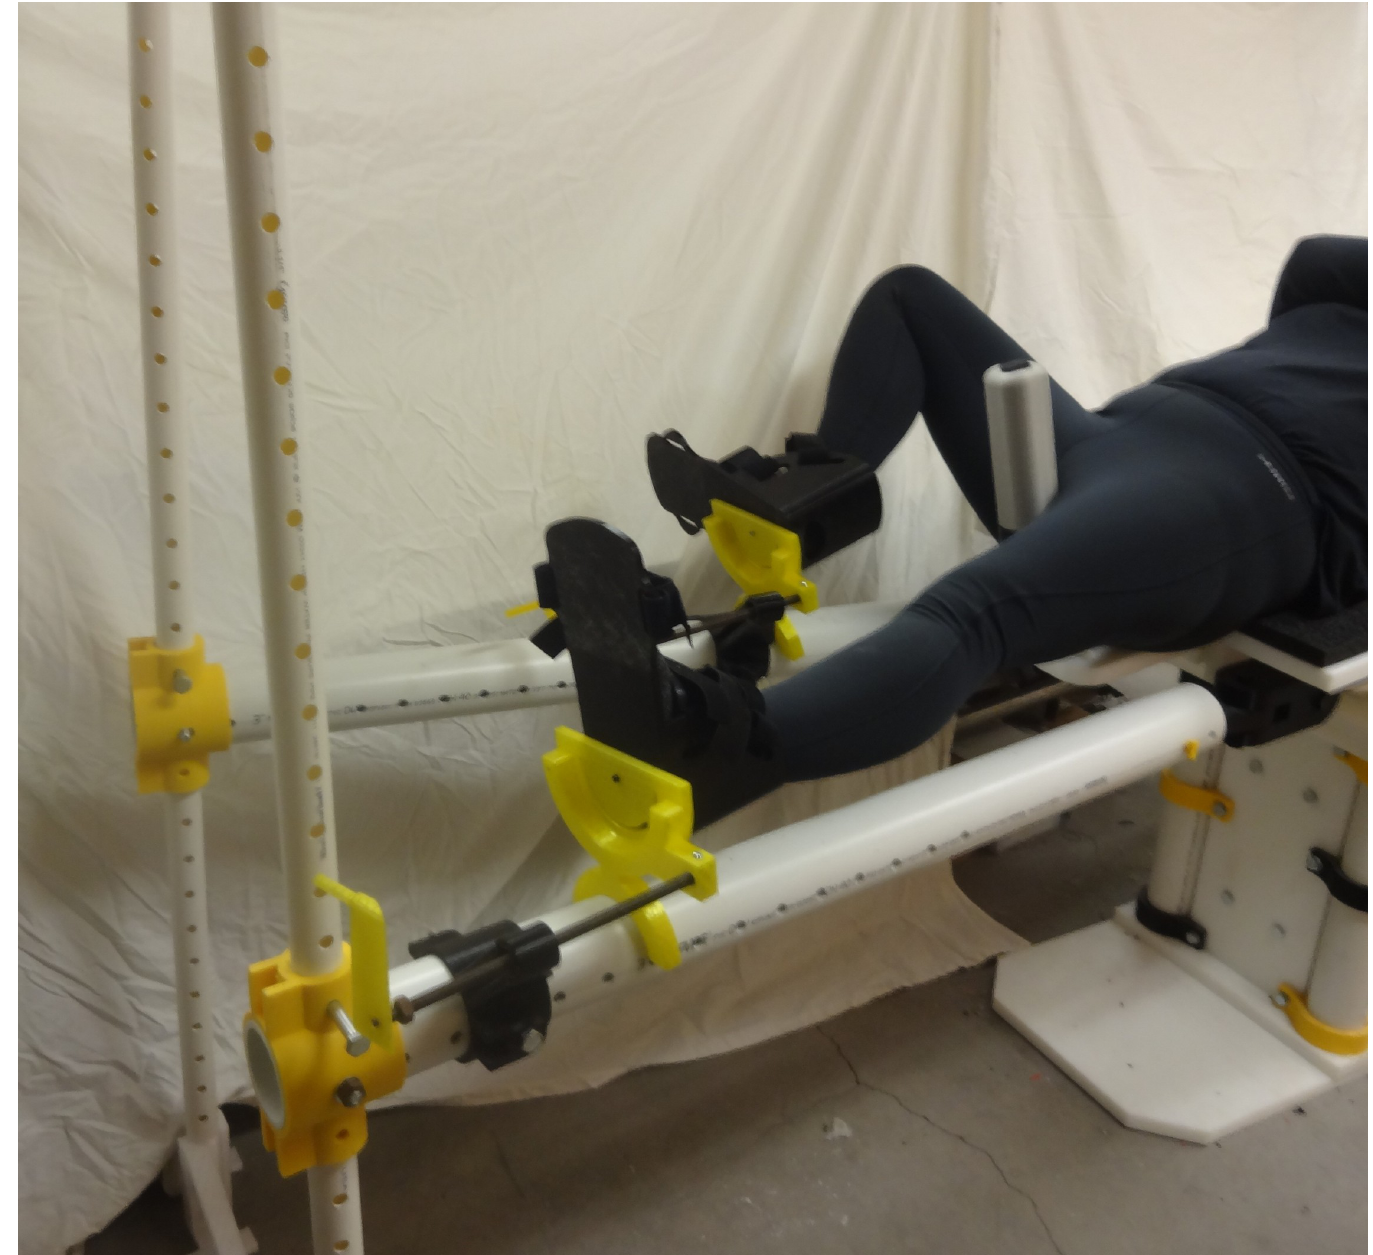
Fig 32. Details of one leg straight and the other flexed and abducted. Note that the leg positioner could have been abducted for this